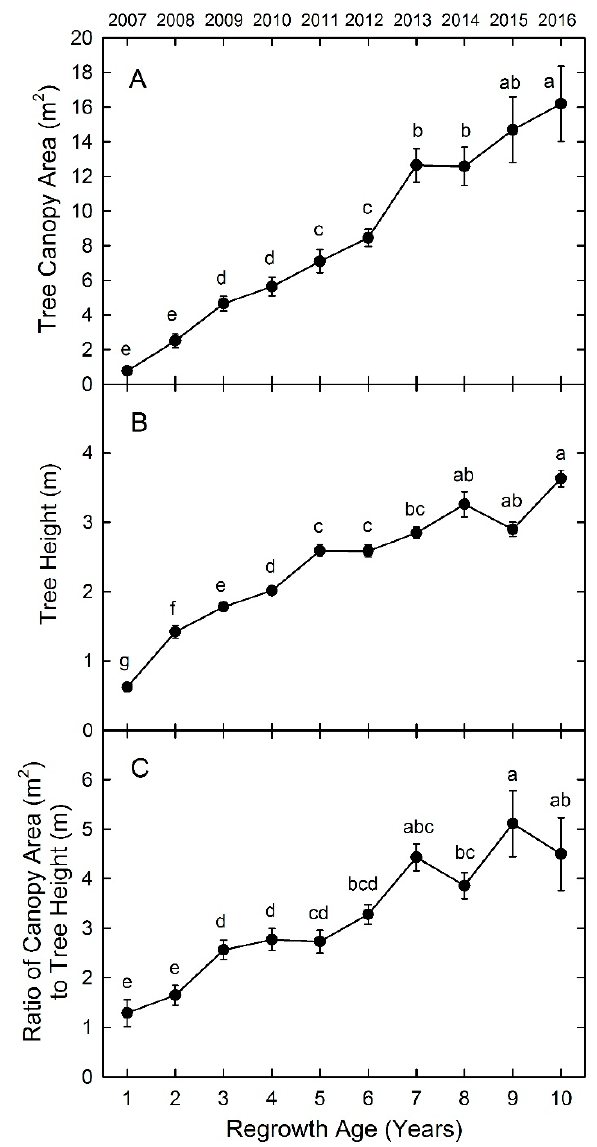
Figure 5. Mesquite canopy area ( A ), height ( B ) and ratio of canopy area to height ( C ) of regrowth mesquite, 1 to 10 years. Vertical bars on each mean indicate ±1 standard error. Means with different letters within each panel are significantly different at p ≤ 0.05.